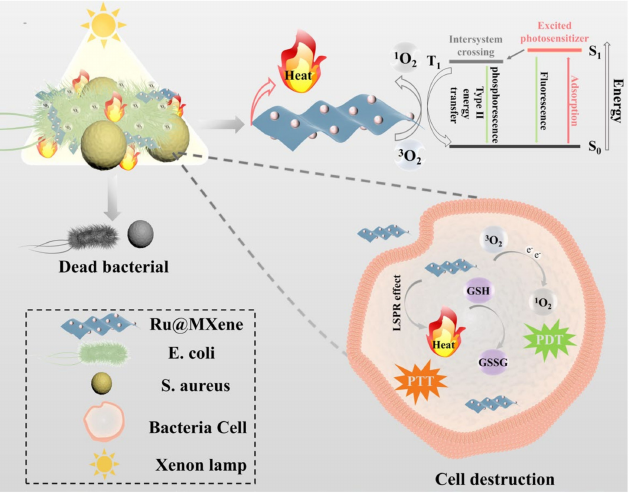
Figure 2. Schematic diagram of Ru@MXene as a photoconverting agent to produce heat and 1 O 2 for achieving PTT/PDT antibacterial